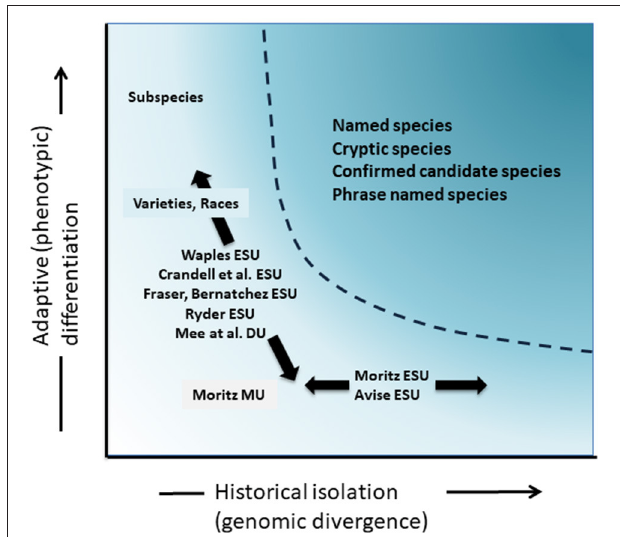
FIGURE 4 | Separation of genetic diversity into two components: adaptive variation that arises through natural selection, and assayed though analysis of phenotypes and historical isolation or neutral divergence assessed through genomic divergence. The darker shaded area above the curve indicates conditions where populations are likely to be considered as separate species under most concepts. Various conservation unit concepts and infra-specific taxonomic categories are shown relative to the two axes of genetic diversity (after Moritz,